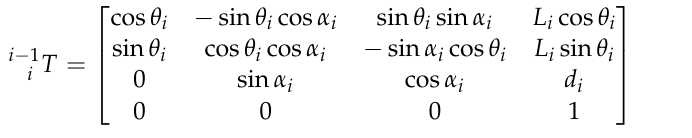
The homogeneous transformation matrix between two adjacent connecting rods is